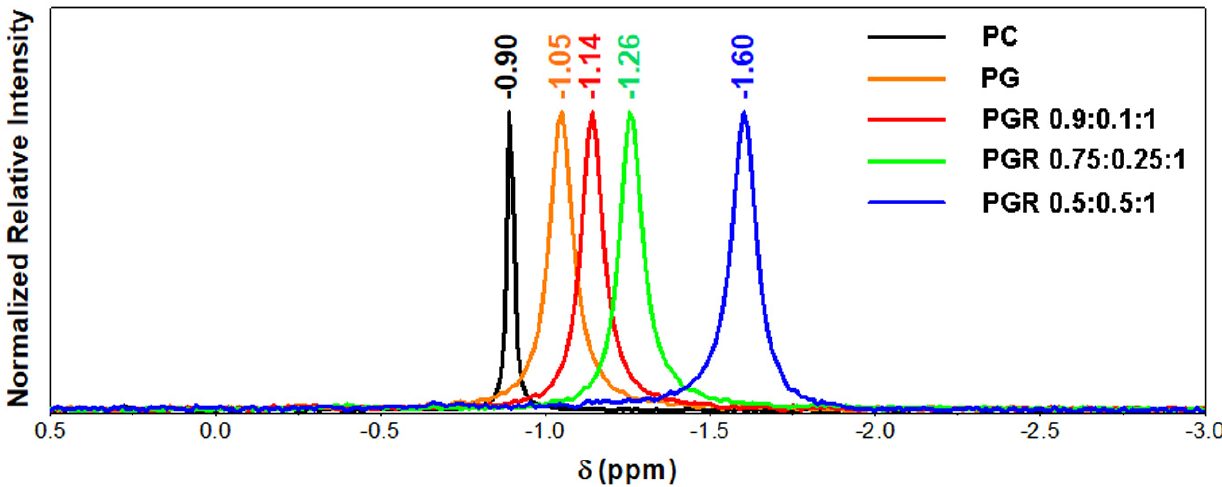
Figure 3. The 31 P NMR spectra of PHYTOGINROSA (PGR) compared to PHYTOGIN (PG) and phosphatidylcoline (PC).